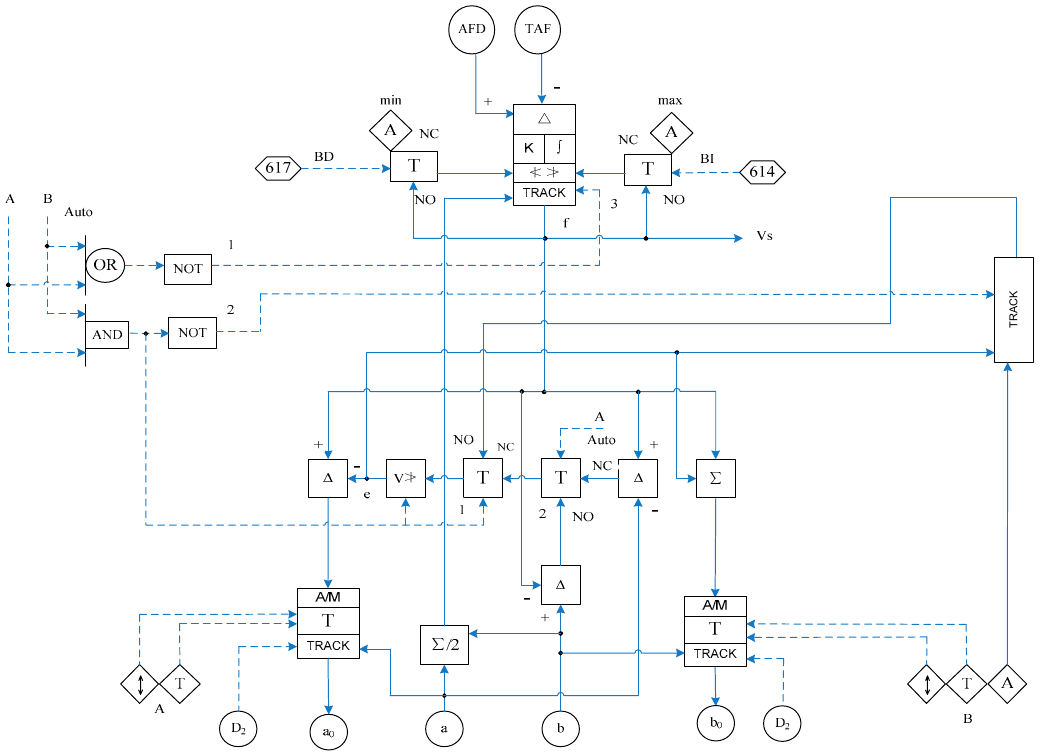
Figure 32. The SAMA diagram of the air volume control system.